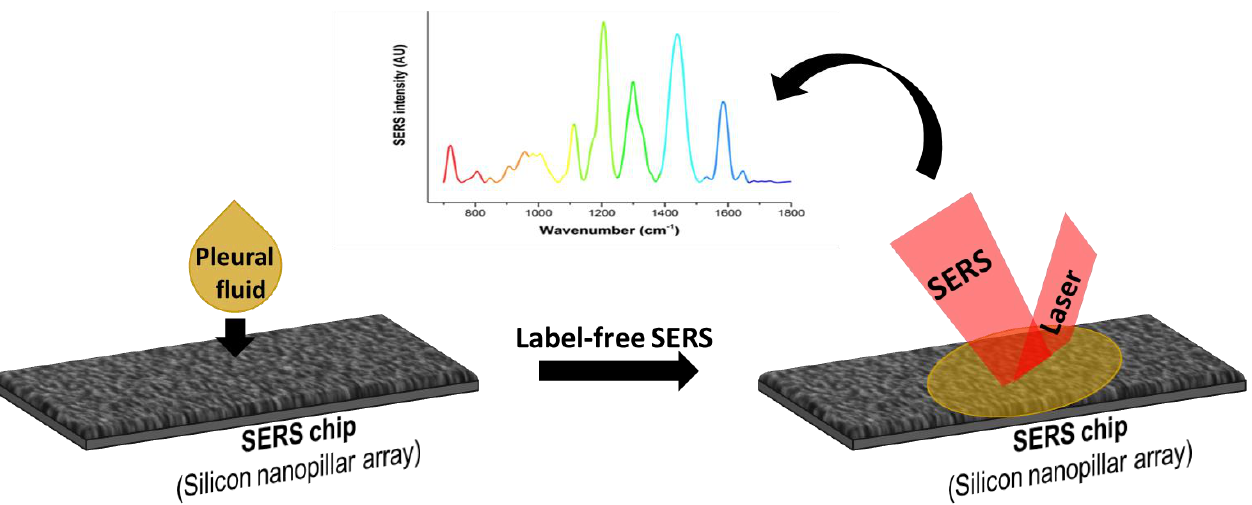
Figure 1. Schematic showing the label-free SERS platform for pleural fluid